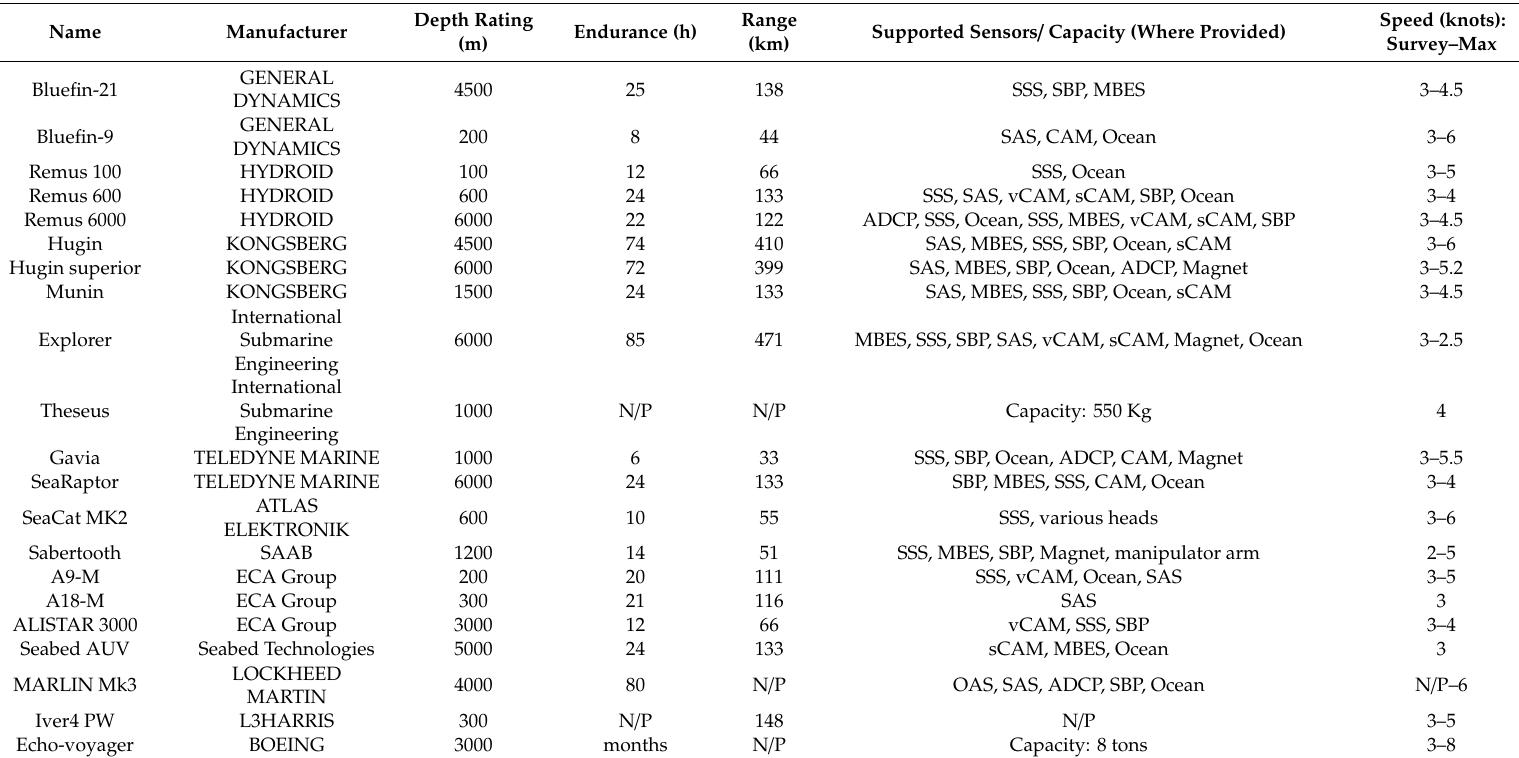
Table 3. AUVs (Autonomous Underwater Vehicles) for carrying underwater sensors to survey the underwater environment of communication